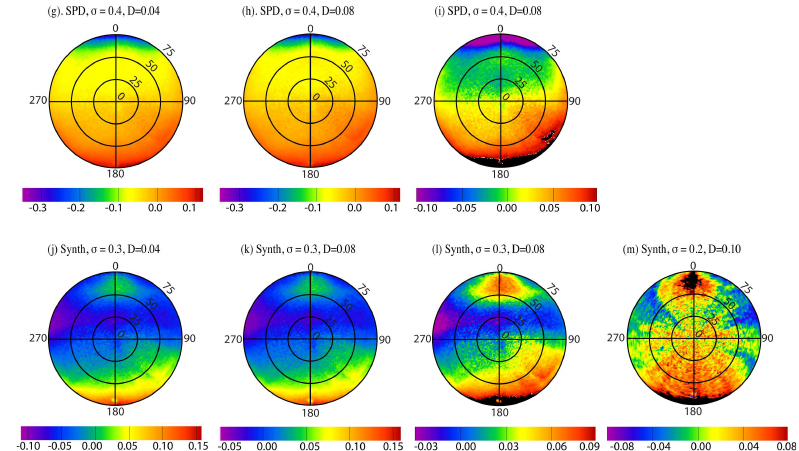
Fig. 7g–m. Difference between derived CAR BRF in the red band and modeled BRF ( R new ) for different slope distributions and sastrugi densities. The images (g–l) show results for flight 2001b (7 April), and the last image (m) shows result for flight 2005a (15 April). Figure 7(g-m) . Difference between derived CAR BRF in the red band and modeled BRF ( R New ) for different slope distributions and sastrugi densities. The images (g-l) show results for flight 2001b (April 7), and the last image (m) shows result for flight 2005a (April 15).